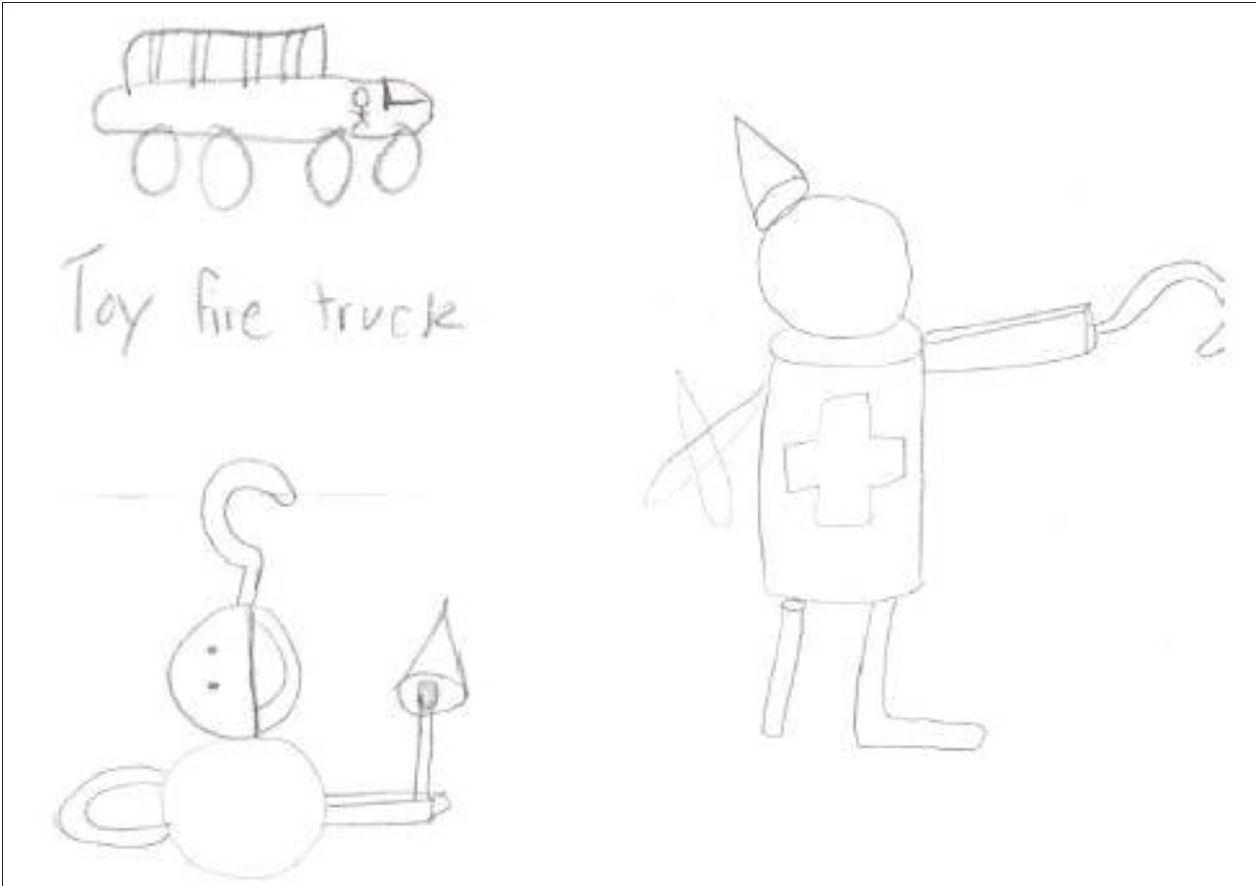
FIGURE 5 | Examples of toy designs in experiment